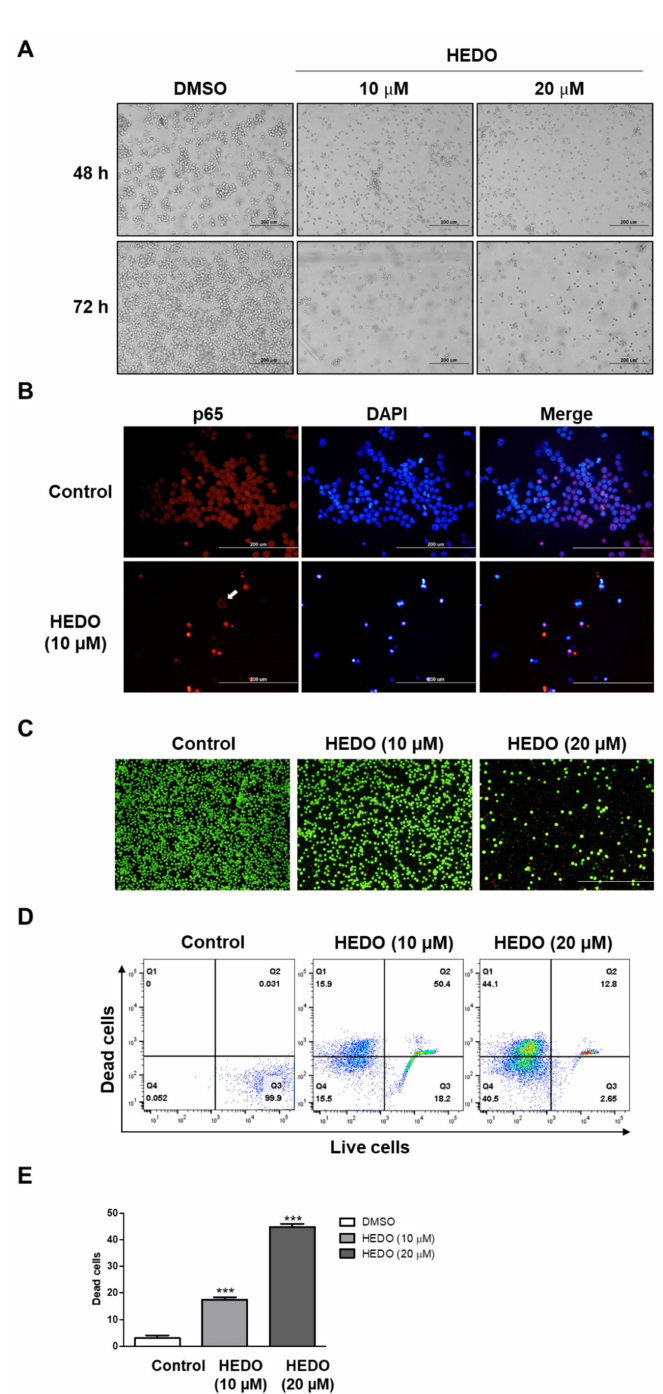
Figure 7. E ff ects of HEDO on morphological changes, p65 nuclear translocation, and cell viability in OCI-LY3 cells. ( A ) Cells treated with HEDO (10 and 20 µ M) show morphological changes that are characteristic of apoptosis at 48 and 72 h post-treatment using phase contrast microscopy (n = 3, 200x magnification, scale bar: 200 µ m). ( B ) E ff ects of HEDO on p65 nuclear translocation in OCI-LY3 cells. OCI-LY3 cells were cultured in the presence or absence of HEDO (10 µ M). The white arrows show that the nuclear translocation of p65 was inhibited by HEDO and the p65 remained in the cytoplasm. ( C ) Merged fluorescence images showing untreated and HEDO-exposed (48 h) OCI-LY3 cells (green fluorescence represents live cells and red fluorescence represents dead cells). ( D ) Flow cytometry analysis of live and dead Jurkat cells with calcein and ethidium homodimer-1 staining. ( E ) Quantification of dead cells. Values indicate the means ± SEM. (n = 3, *** p ≤